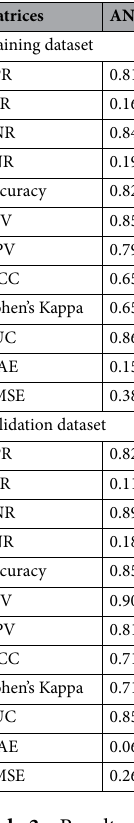
Table 3. Results of validation measures based on training and validation